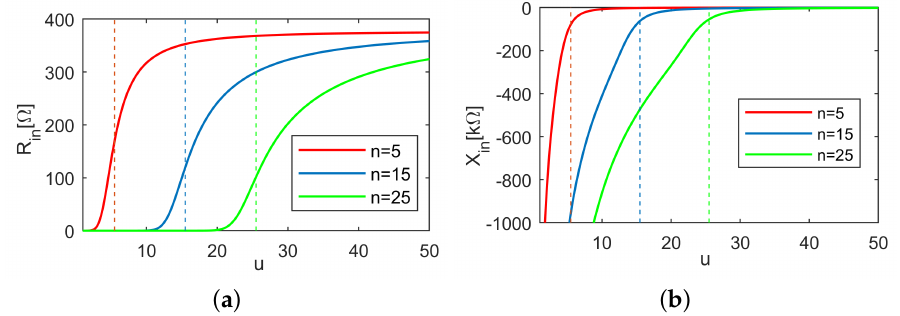
Figure 6. Generalized input impedance of TM nm mode for n = 5,15, and 25. ( a ) Real part. ( b ) Imaginary part.